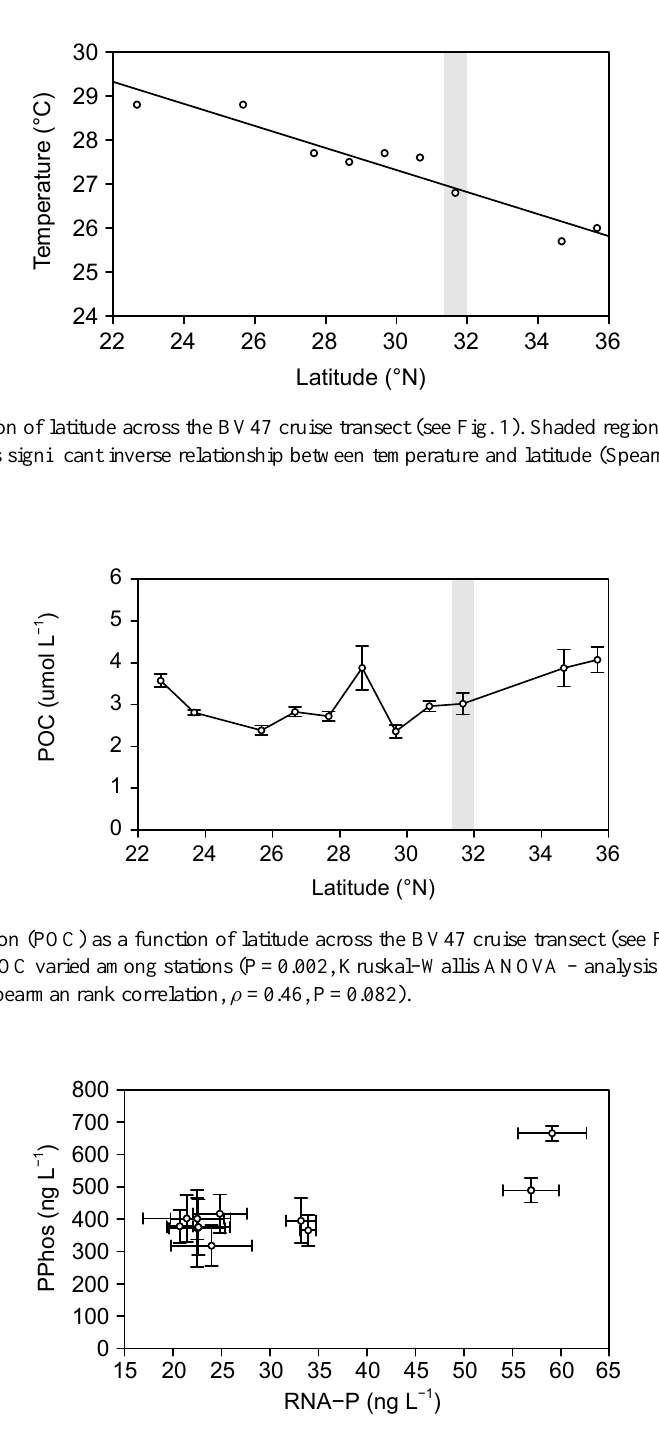
Fig. A3. Particulate phosphorus (PPhos) as a function of phosphorus in RNA (RNA-P, calculated as 9% RNA mass). Total PPhos was not significantly correlated with RNA-P (Spearman rank correlation, ρ =0.35,